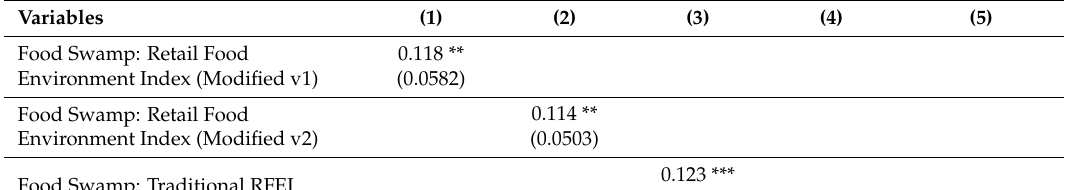
Table A4. OLS coefficient estimates of food swamps on obesity